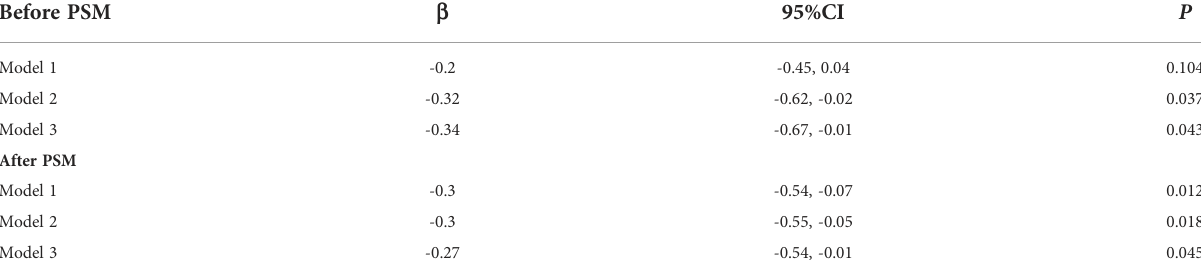
TABLE 3 Association between GLP-1RAs use and NFS before and PSM. Before PSM